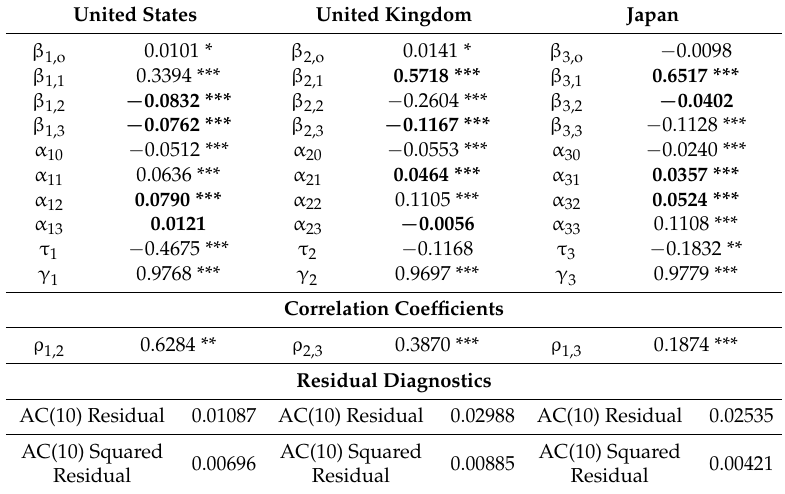
Table A5. Estimation from the multivariate MVR-EGARCH model (conventional equities—pre-crisis). United